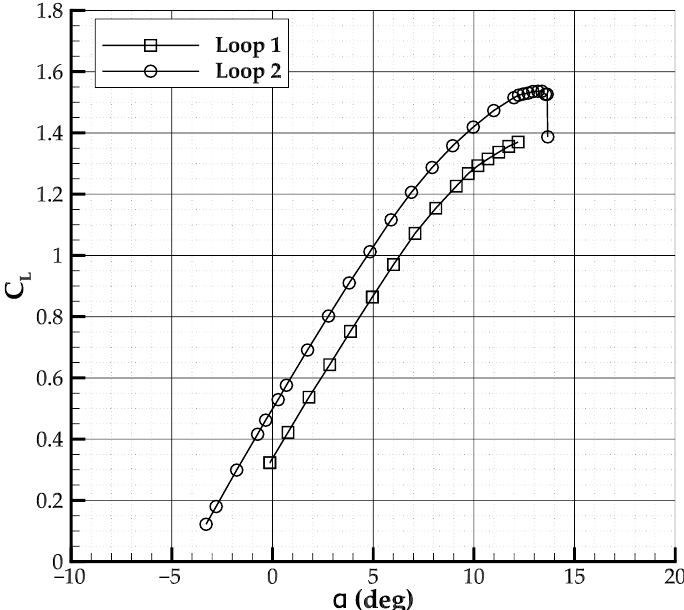
Figure 10. Comparison of the lift coefficient curves for the two design loop. V = 35m/s, Re =